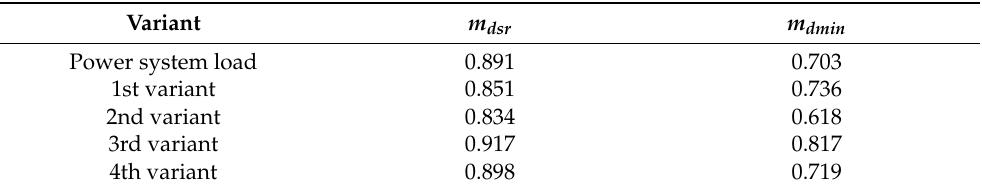
Figure 1. Comparison of the actual system load curve with simulated load variants of the system by charging stations. Table 5. Exemplary daily load variability indices for various variants regarding the distribution of electric vehicle charging within 24 h.